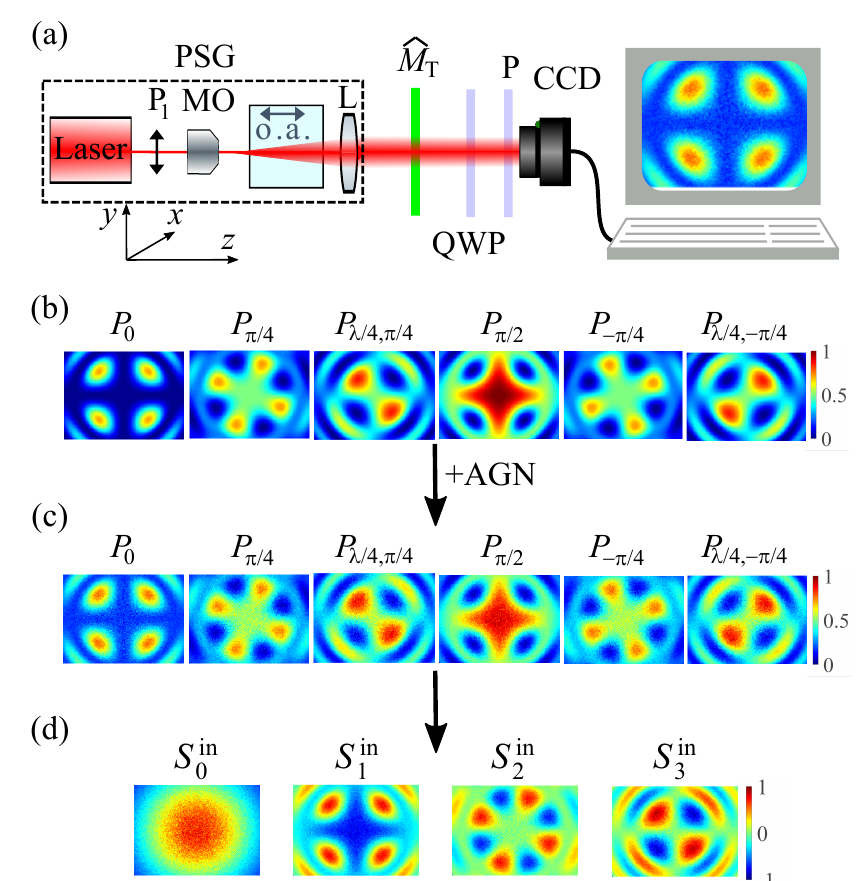
Figure 1. ( a ) Experimental setup; ( b ) theoretical images for the input beam; ( c ) theoretical images with additive Gaussian noise (AGN); ( d ) calculated Stokes parameters from noisy